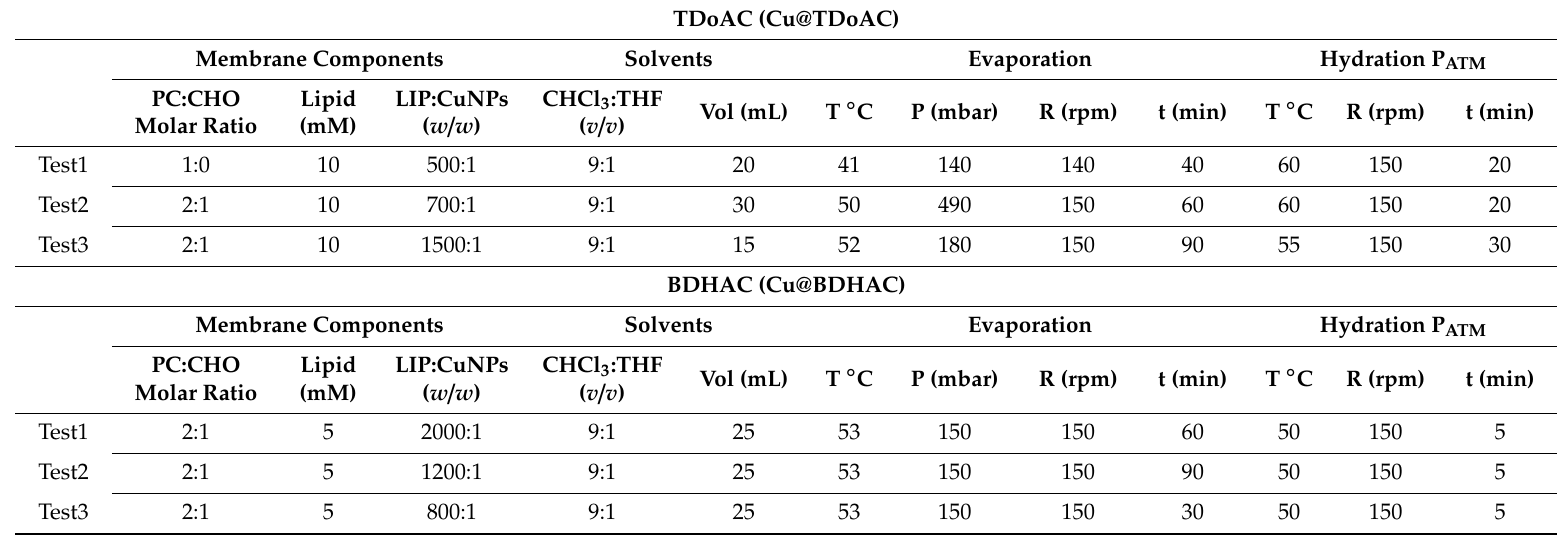
Table 1. Experimental parameter setting for the inclusion in nanovesicles (NVs) of CuNPs stabilized by tetra-dodecyl ammonium chloride (TDoAC—Cu@TDoAC) and benzyl-dimethyl-hexadecyl-ammonium chloride (BDHAC—Cu@BDHAC). The ratio of membrane components, phosphatidylcholine and cholesterol (PC:CHO), their lipid concentration and relative amount of lipid to nanoparticle composition (LIP:CuNPs) are listed for each test. Specifications of the solvents used, and temperature (T), pressure (P), rotation speed (R), and time (t) for evaporation and hydration steps are also